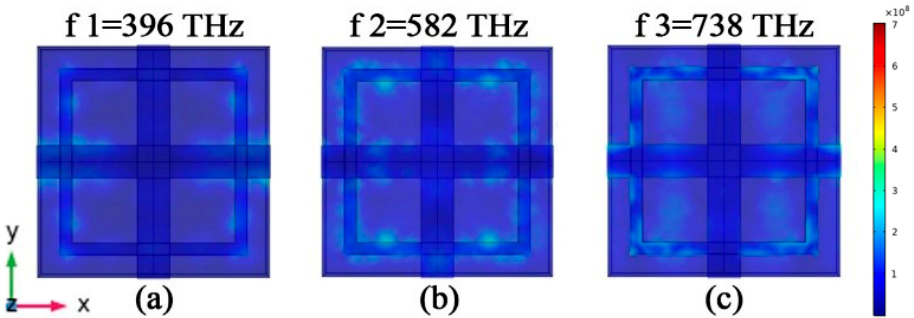
Figure 3. ( a ) Electric field diagram for a frequency of 396 THz. ( b ) Electric field diagram for a frequency of 582 THz. ( c ) Electric field diagram for a frequency of 738 THz.